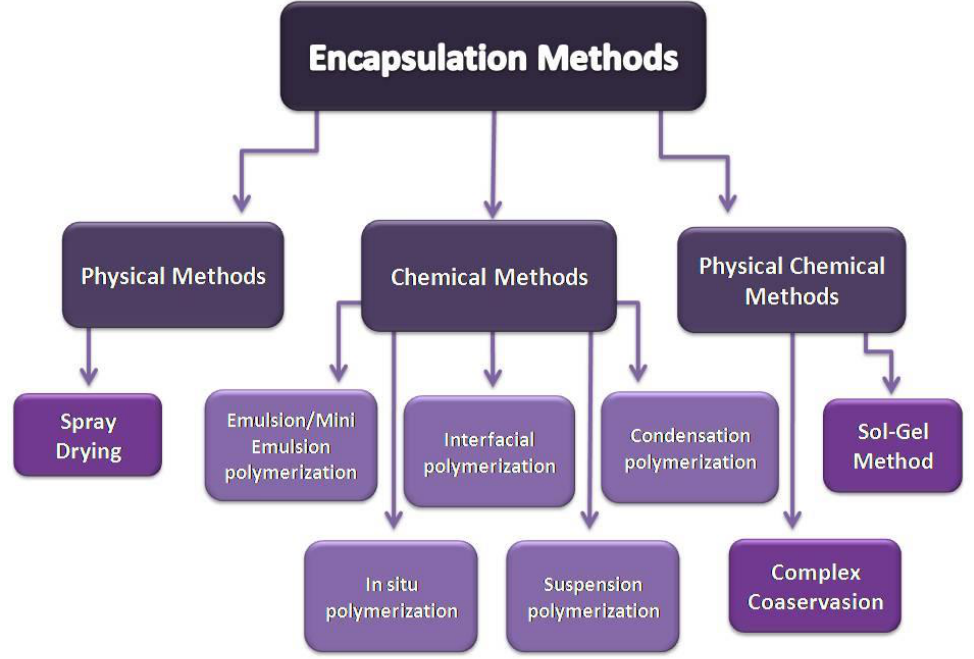
Figure 3. Physical, chemical, and physicochemical methods of encapsulation.